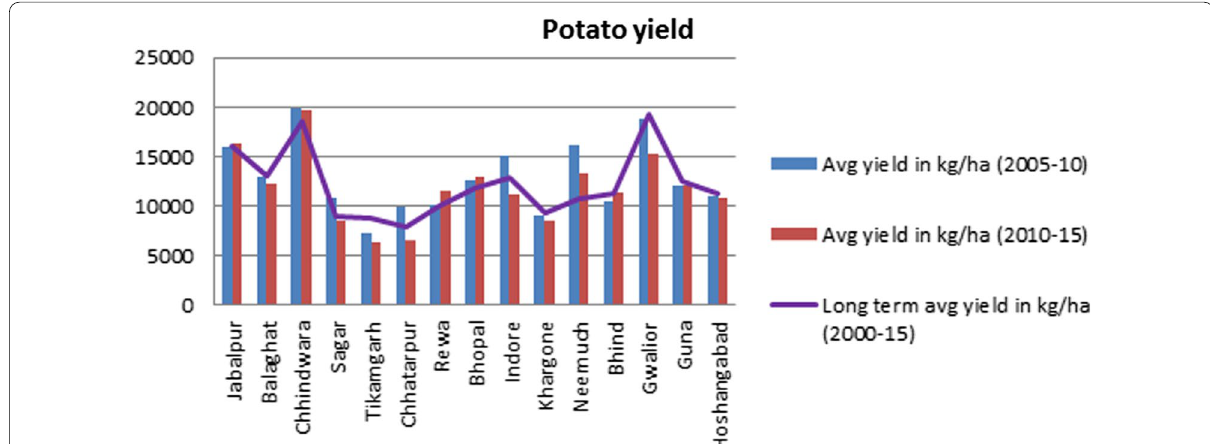
Fig. 17 Comparison of the long-term average potato yield with the average yield during the years 2005–2010 (phase I) and 2010–2015 (phase II) and also among phase I and II yield in the selected districts of Madhya